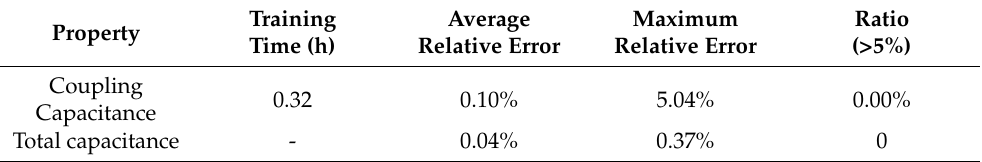
Table 10. The predictive performance of DNN-3 on the coupling capacitances and total capacitances.